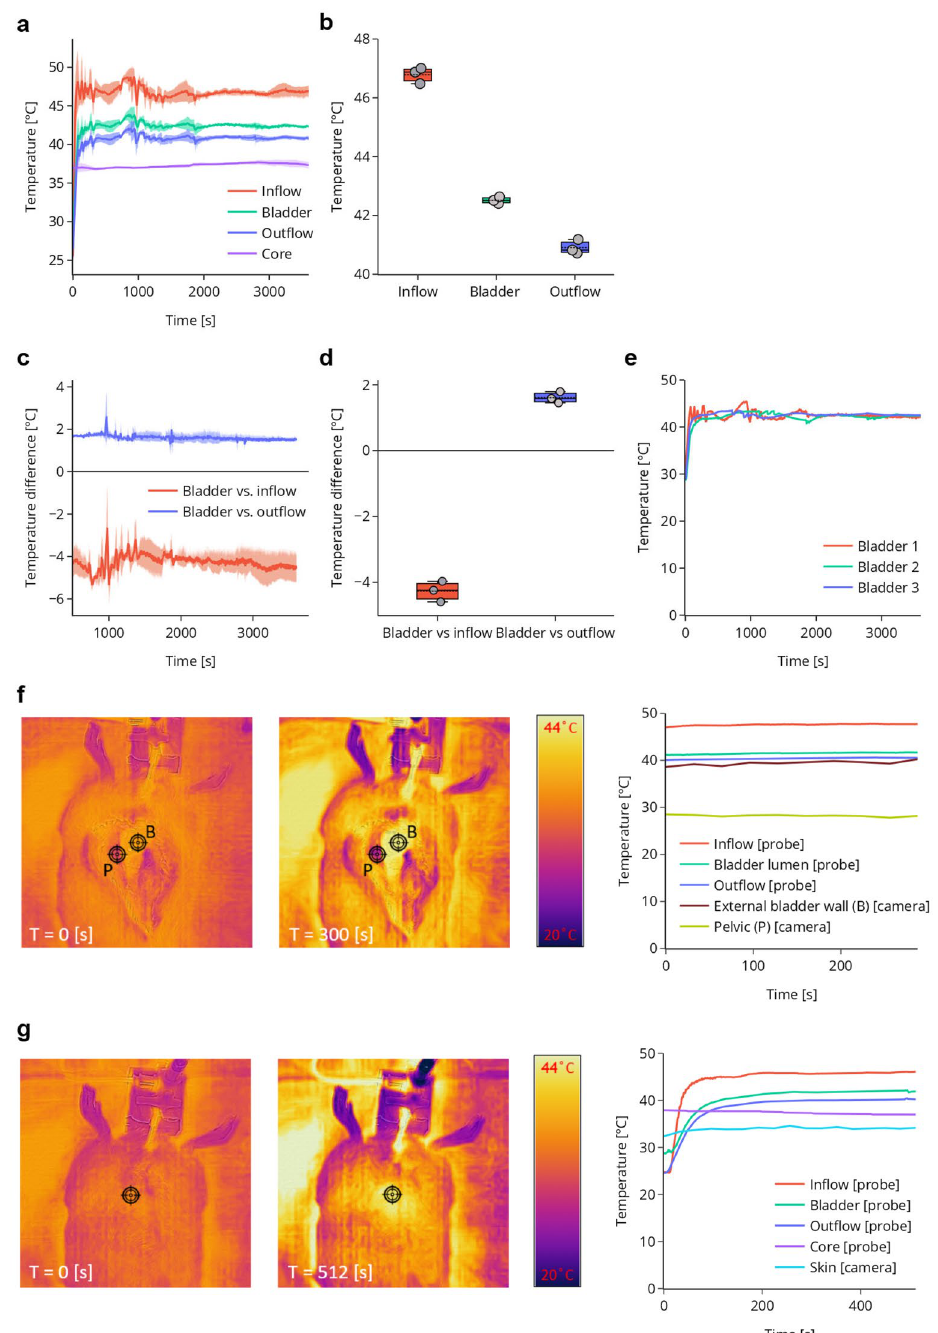
Figure 4. Temperature measurements during HIVEC in live anesthetised rats. ( a ) Average temperature kinetics during the entire treatment. ( b ) Average temperatures during the steady-state phase of the treatment. ( c ) Temperature differences between the bladder lumen and inflow/outflow channels during the steady state phase. ( d ) Average temperature difference between bladder lumen and inflow/outflow channels during the steady-state phase of treatment. ( e ) Individual bladder lumen temperature kinetics during the entire procedure. ( f ) Left; thermal camera image from rat 2 at the start of the procedure and after 500 s, Right; corresponding core and skin temperatures, measured with the thermal camera. ( g ) Left; thermal camera image at start and after 300 s, with opened abdomen, exposing the pelvis and bladder wall. Right; corresponding (other) temperatures in the system. Data are mean ± SD. Temperature measurements were gathered from 3 independent experiments. Thermal camera imaging measurements were performed in all rats and showed consistent heating kinetics between individual